Question: What type of chart is this?
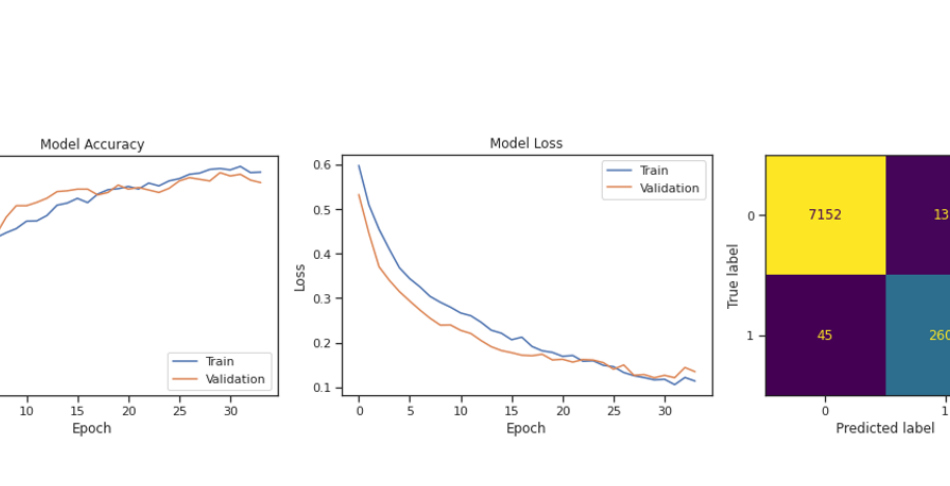
Answer: heatmap